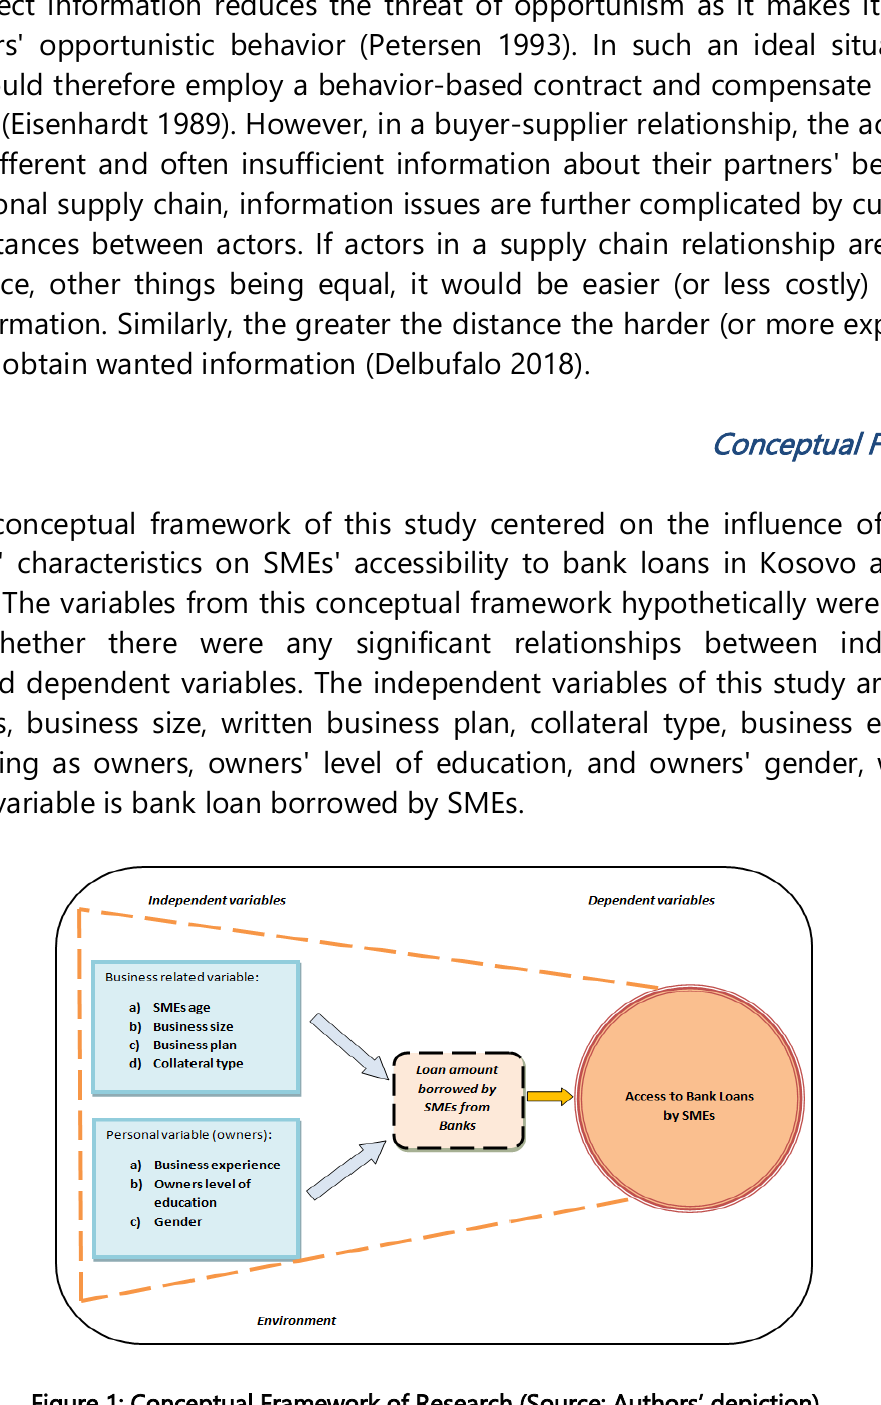
Figure 1: Conceptual Framework of Research (Source: Authors‟